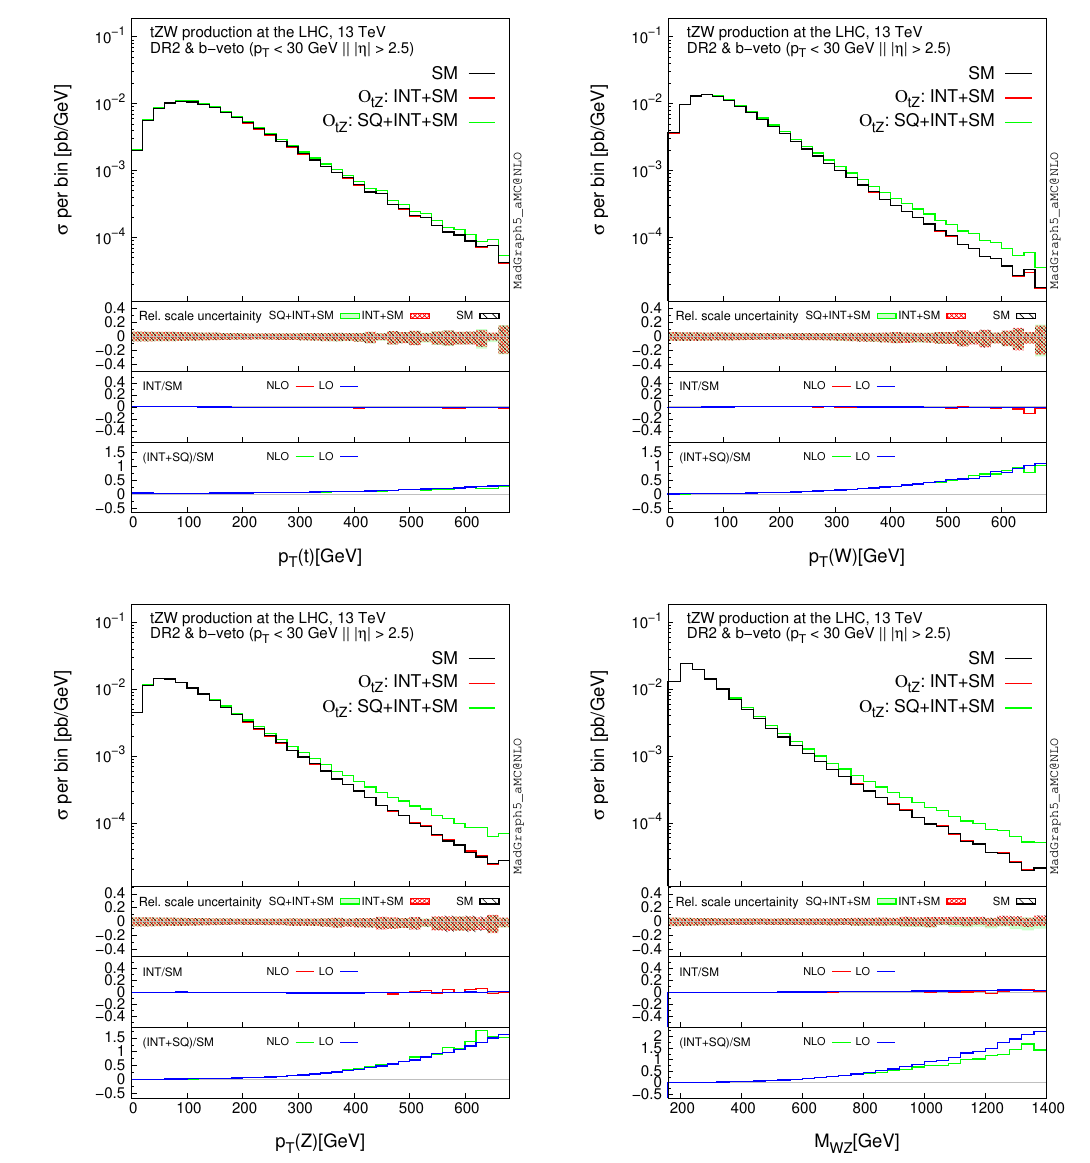
Figure 11 . Same as figure 9 but for the O